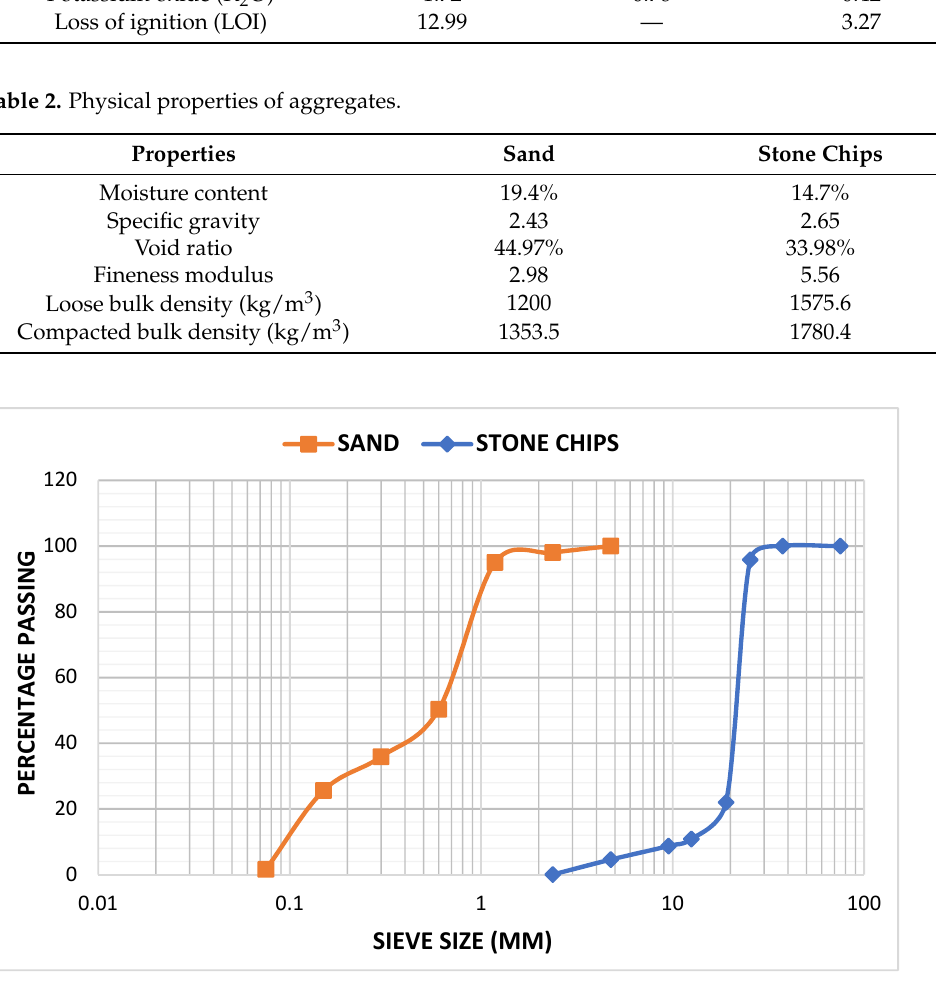
Figure 1. Grading curve of fine and coarse aggregate used in this study.